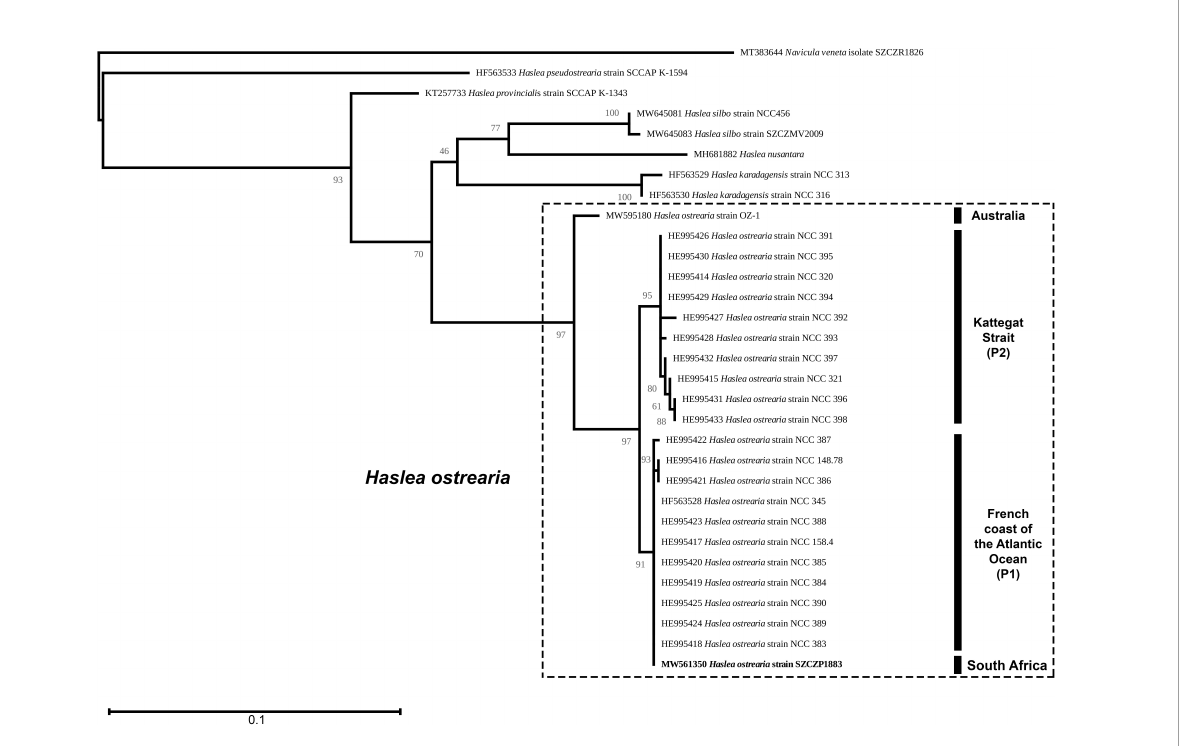
FIGURE 8 Maximum Likelihood phylogenetic tree inferred from an alignment of the partial cox1 gene of Haslea spp. and rooted with Navicula veneta (Log-likelihood: -2085.461960). The scale indicates the number of substitutions per site. P1 – Progeny of the pair NCC148.78 (Bay of Bourgneuf, France) x NCC320 (Kattegat Strait). P2 – progeny of the pair NCC158.4 (Bay of Bourgneuf, France) x NCC321 (Kattegat Strait), from Gastineau et al.,